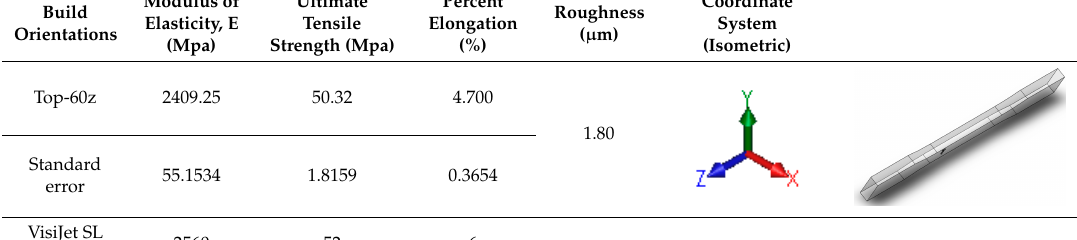
Table 2. Tensile test average results and mean surface roughness for all unique configurations.